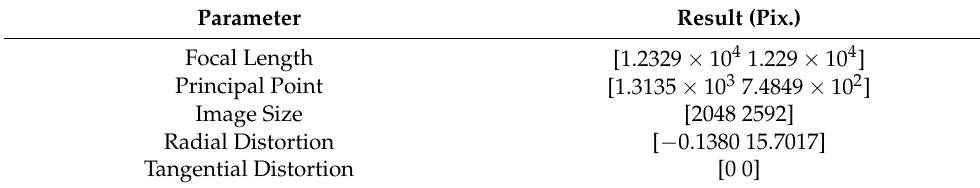
Table 3. Some parameters of the